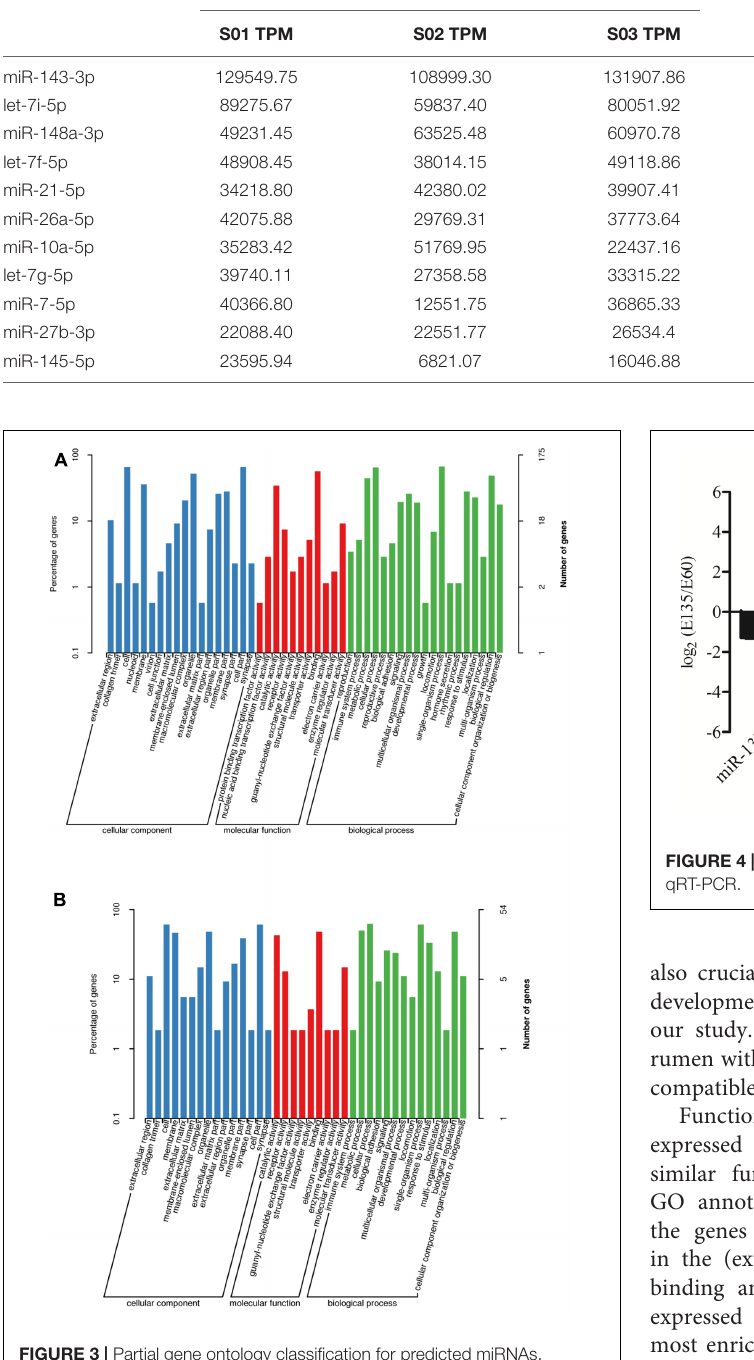
FIGURE 3 | Partial gene ontology classification for predicted miRNAs. (A) Gene ontology classification for differentially expressed miRNAs. (B) Gene ontology classification for top 10 highly expressed miRNAs.